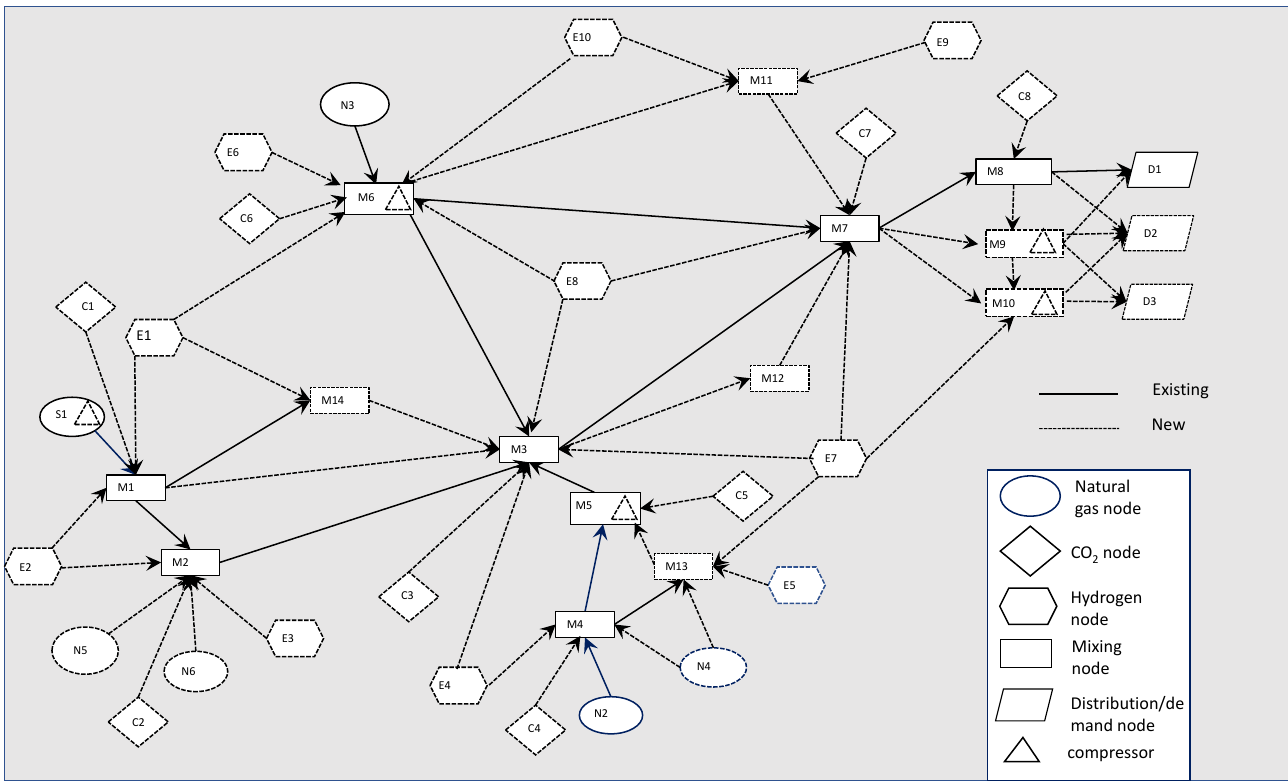
Figure 2. Superstructure for renewable injection in the Ontario natural gas grid (pipeline distance not to